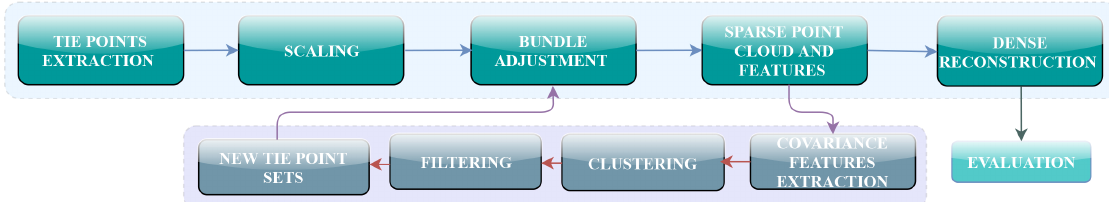
Figure 2: The flowchart of the implemented pipeline. An automatic filtering procedure developed in Python (lower blocks) enriches the traditional photogrammetric pipeline (upper blocks) for improving 3D dense reconstruction results.